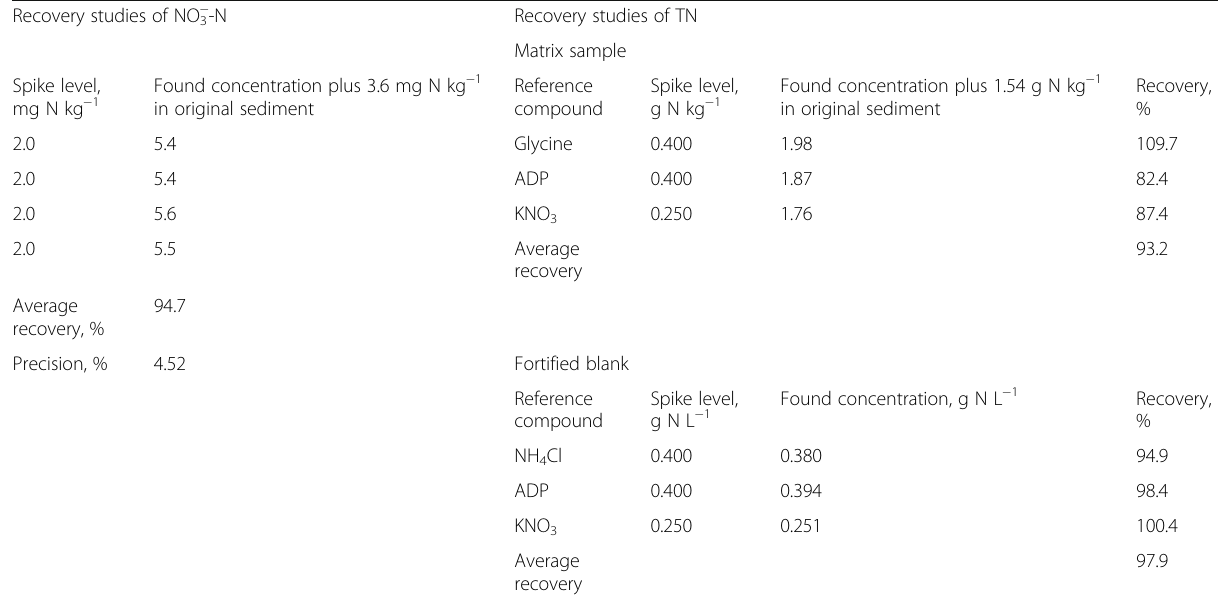
Table 1 The recoveries for N species using spiked sediments and reagent water Recovery studies of NO 3 − -N Recovery studies of TN Matrix